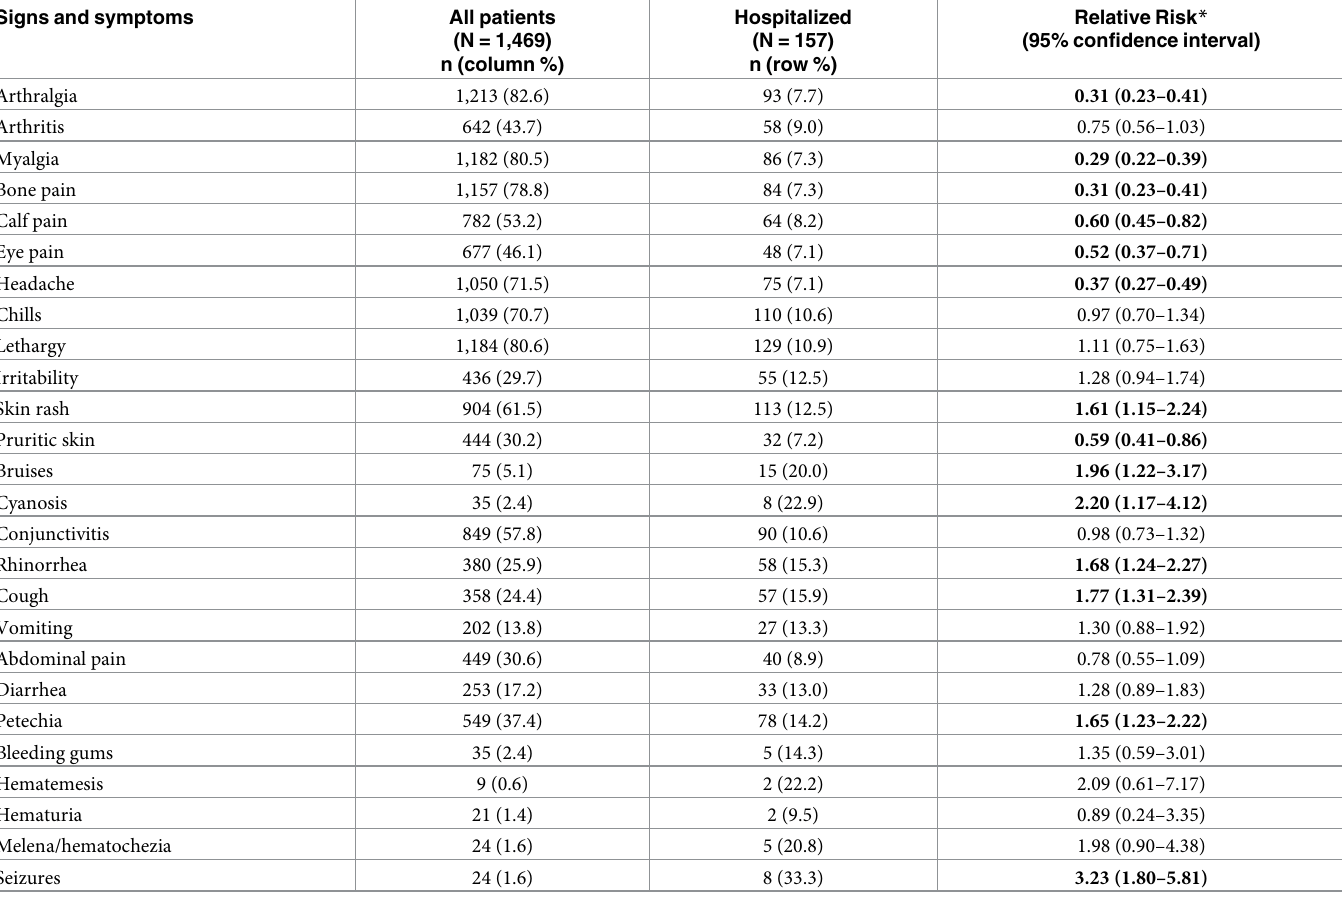
Table 3. Signs and symptoms identified during evaluation at the emergency department of hospitalized and non-hospitalized, laboratory-positive chikungunya virus-infected patients enrolled in the sentinel enhanced dengue surveillance system, May–December, 2014 (N = 1,469).